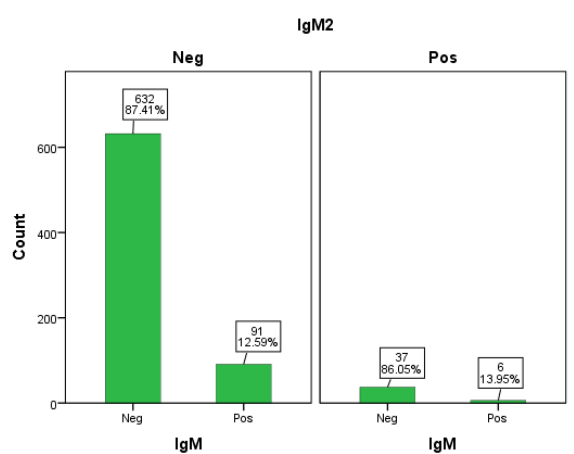
Figure 1. IgM in Two Time Points. Note . IgM: Immunoglobulin M; IgG: Immunoglobulin G. IgM and IgM2 are for the first second stages, respectively. Neg: Negative; Pos: Positive.